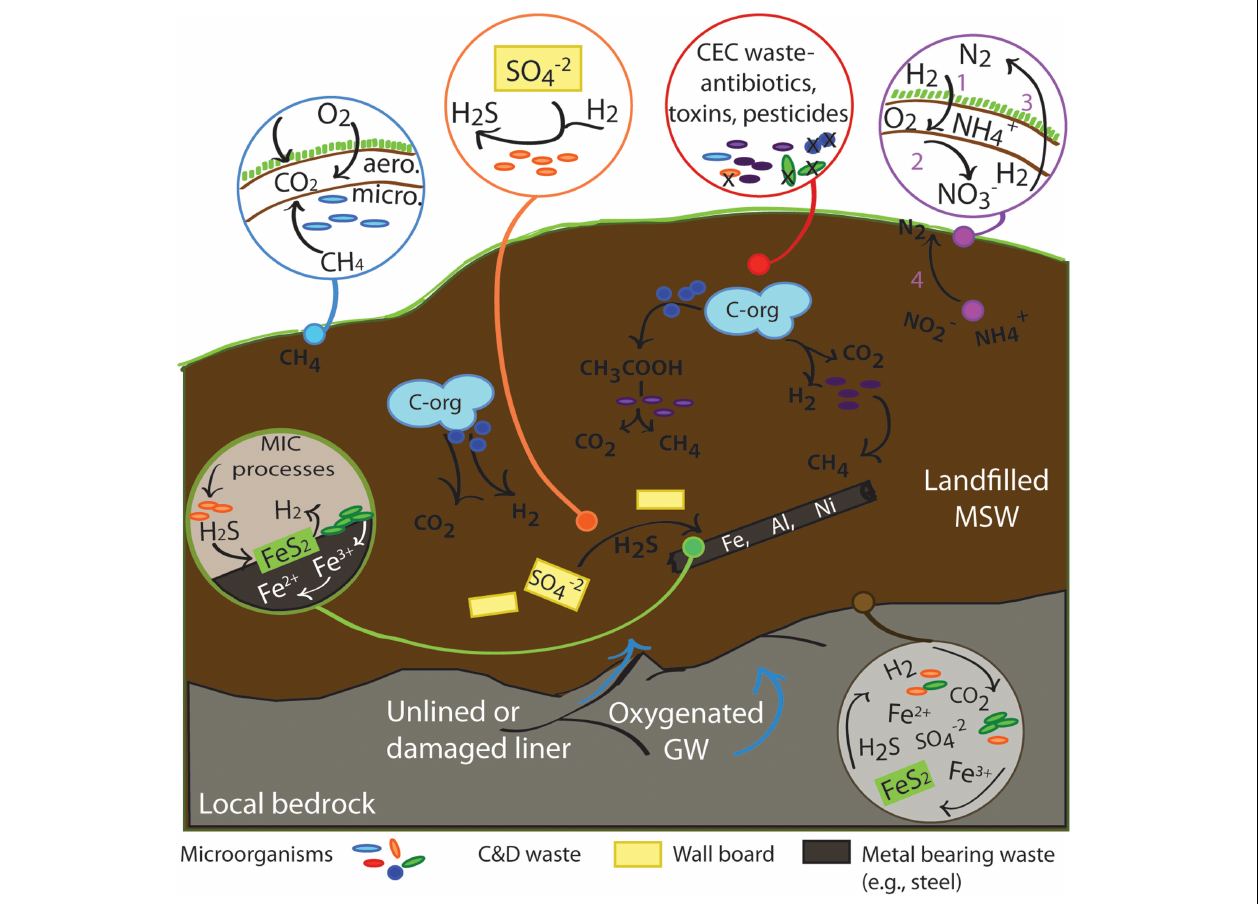
FIGURE 3 | Generalized landfill ecosystem processes, focusing on microbial metabolic functions. Breakdown of organic carbon followed by methanogenesis is represented in the mid-figure. Circular callouts zoom in on specific processes mentioned in the text. Blue callout: Surface and near surface soil processes of methanogenesis and methanotrophy - linked to reactions 1–9 in Table 1 . Red callout: Highlighting potential impact of CECs added to landfill ecosystems. CECs may either boost or suppress microbial metabolic processes, or kill specific groups of organisms. Purple callout: Nitrogen cycle processes. Numbered steps 1–3 indicate a simplified nitrogen cycle in near surface environments, and ANAMMOX at in anaerobic areas - linked to reactions 33–39 in Table 1 . Orange callout: highlights sulfur cycling opportunities that can occur when C&D waste is prevalent - linked to reactions 10, 27, 28 in Table 1 . Green callout indicates potential for MIC and coupling to products of sulfur cycling - linked to reactions 12–14, 18–21, 23, 24, 27–32, and 40–47 in Table 1 . Brown callout indicates the potential chemoautotrophic coupling of reactants across redox boundaries at the microscale when landfill ecosystems encounter exposed bedrock, as may be the case in an unlined or damaged liner - linked to reactions 10–32 in Table 1